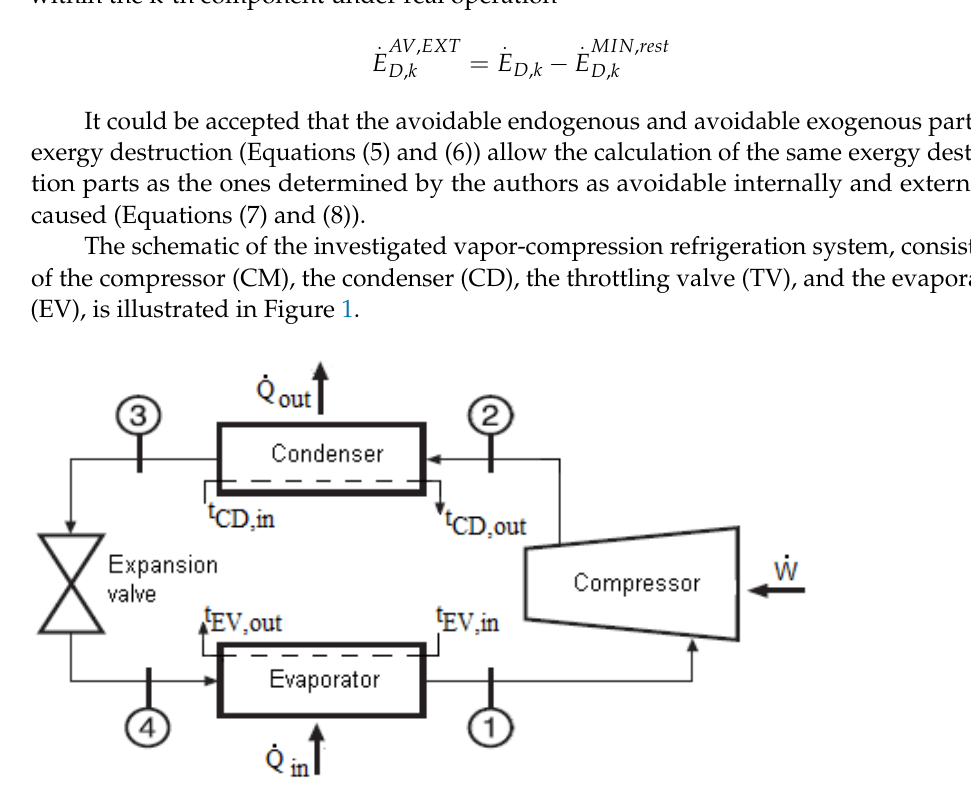
Figure 1. Schematic of the investigated vapor-compression refrigeration system: 1–4—stream numbers. The analysis was performed for a refrigeration system having a cooling capacity of 100 kW [2]. Air was used as a secondary working fluid for the both the evaporator and condenser. The following assumptions were made [2]: (i) in the evaporator, air was cooled from − 5 ◦ C down to − 15 ◦ C; (ii) in the condenser, ambient air was heated from 20 ◦ C up to 30 ◦ C; (iii) the minimal temperature difference within the evaporator (i.e., between air and refrigerant) and within the condenser (i.e., between refrigerant and